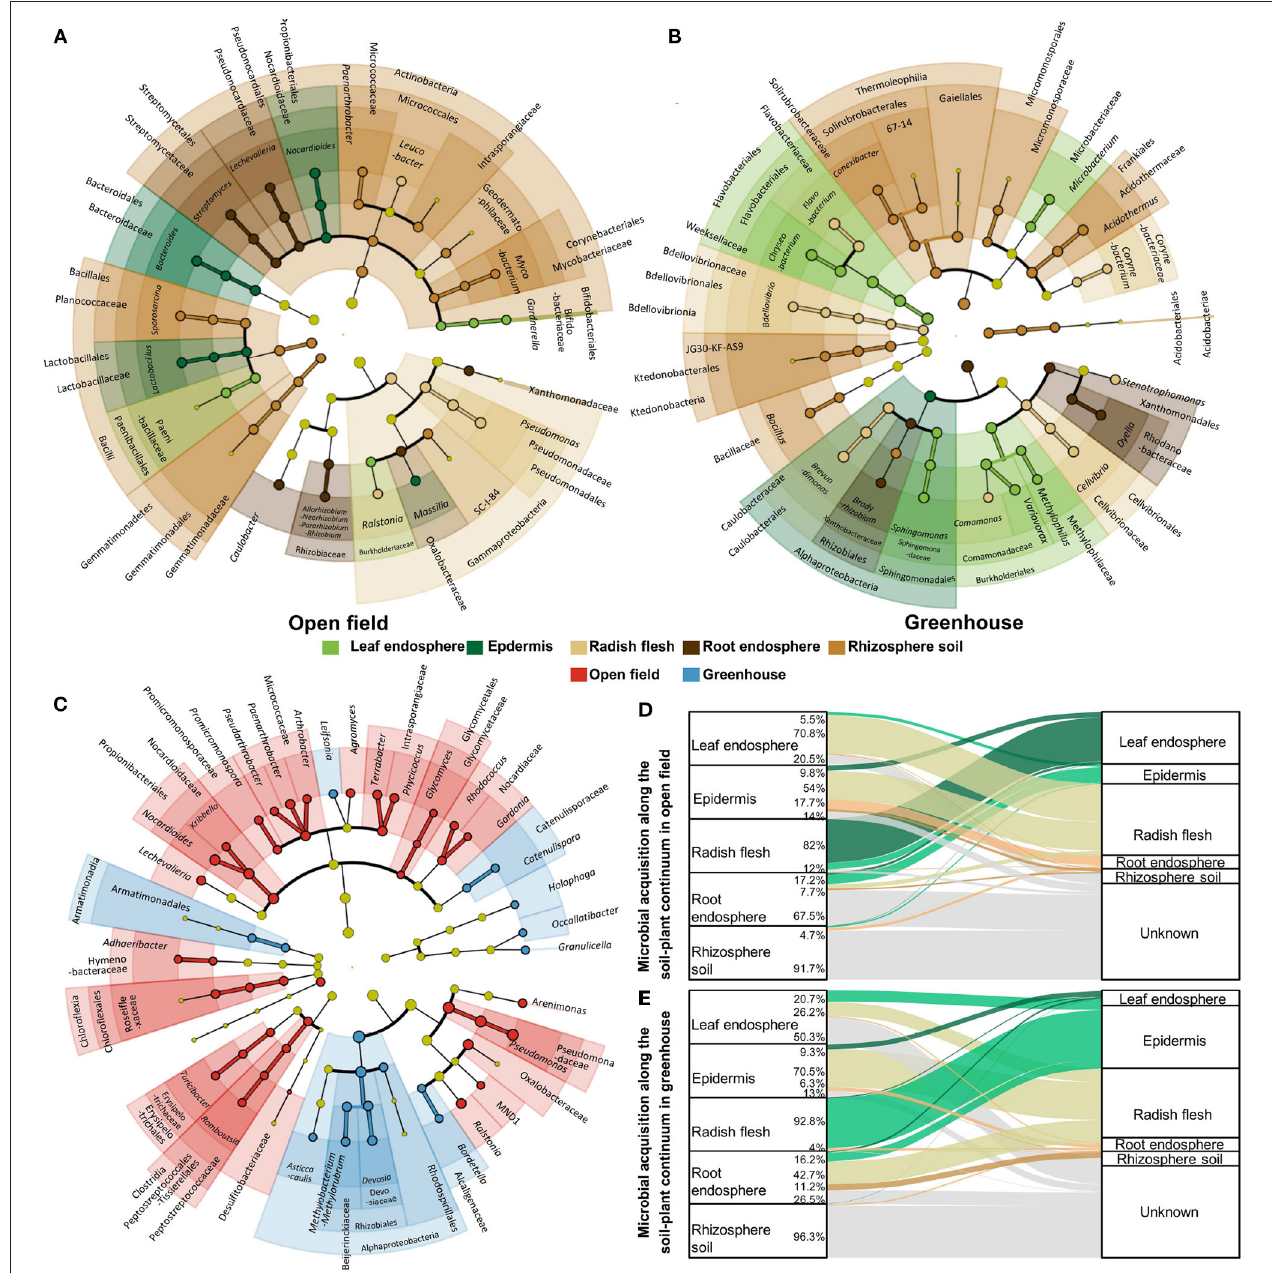
FIGURE 4 | Biomarker analysis for each ecological compartment in open field (A) and greenhouse (B) , and biomarker analysis for both field and greenhouse environments (C) . Different colors indicate different groupings, showing biomarkers from class level to genus level from inside to outside, and light yellow indicates the absence of biomarkers in this classification. Microbial source analysis of ecological compartments in open field (D) and greenhouse (E)